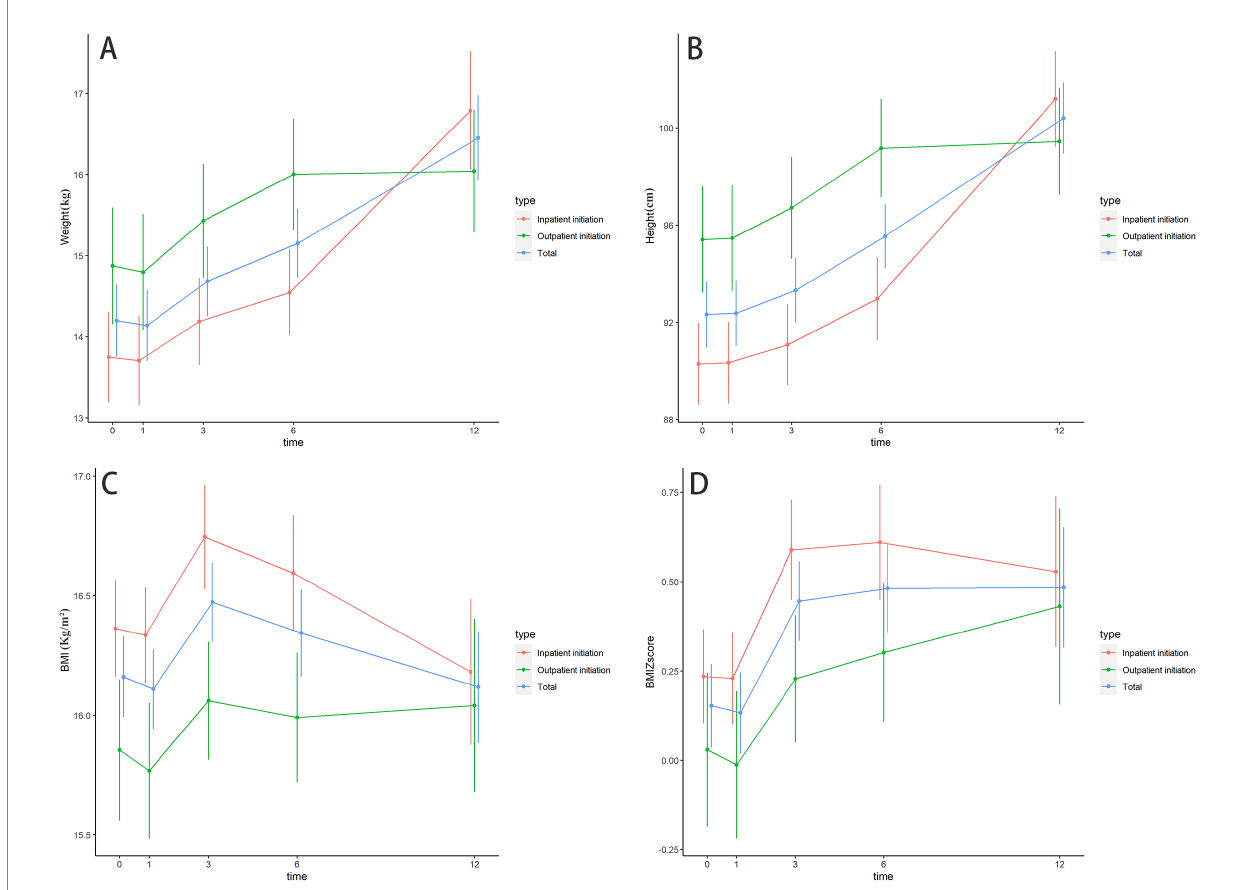
FIGURE 2 The changes in the growth of patients at different follow up times. (A) The changes in the weight of patients at different follow up times; (B) The changes in height of patients at different follow up times; (C) The changes in BMI of patients at different follow up times; (D) The changes in BMI Z-score of patients at different follow up